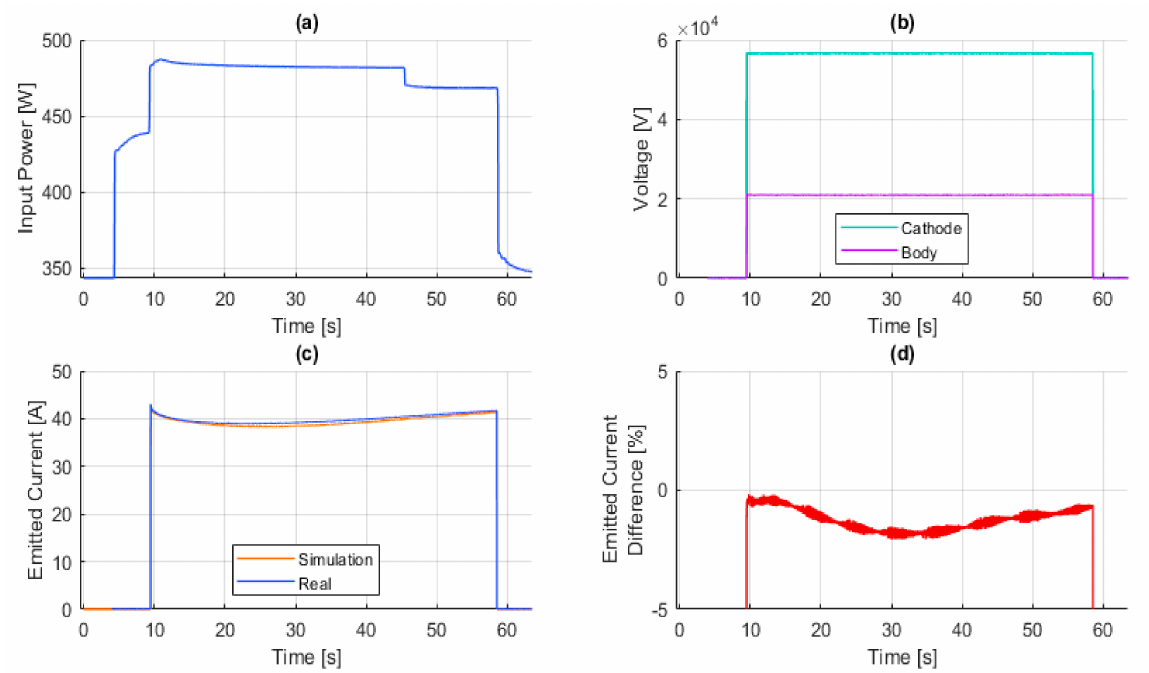
Figure 15. Shot 6730, comparison between the lumped model and experimental results. ( a ) The input sequence of heating power, ( b ) input sequence of accelerating voltage, ( c ) comparison between the experimental and simulated time evolution of beam current, and ( d ) percentual error between the